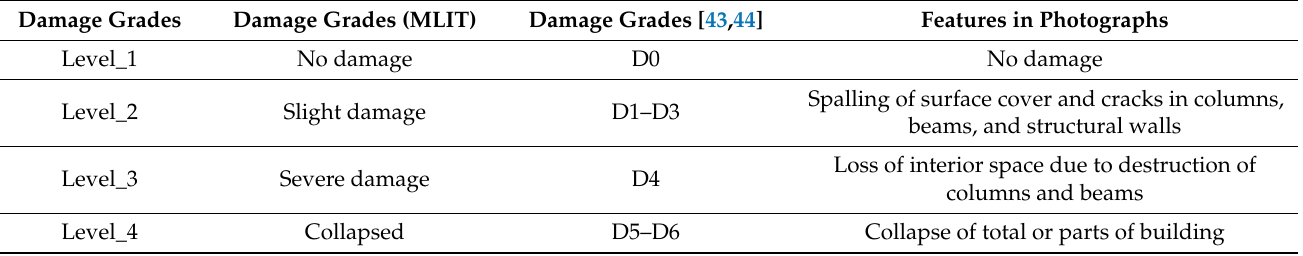
Table 1. Definition of the damage grades used in this study [42–44].